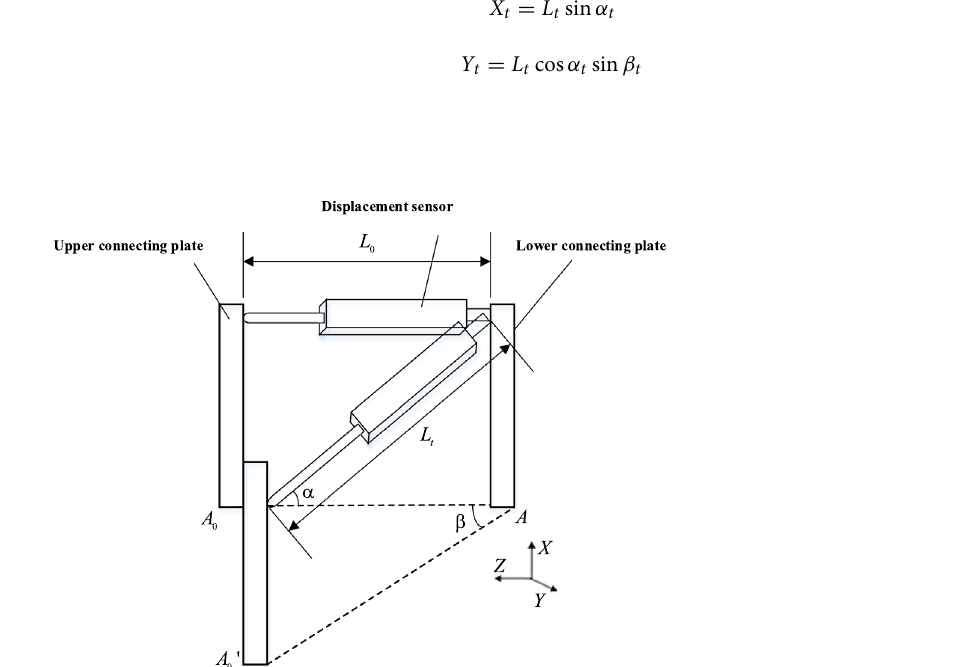
Figure 4. Schematic diagram of three-dimensional displacement measurement of isolation bearing (The figure was generated by Microsoft Visio Professional 2016 (https:// www. micro soft. com/ zh- CN/ downl oad/ detai ls. aspx? id=